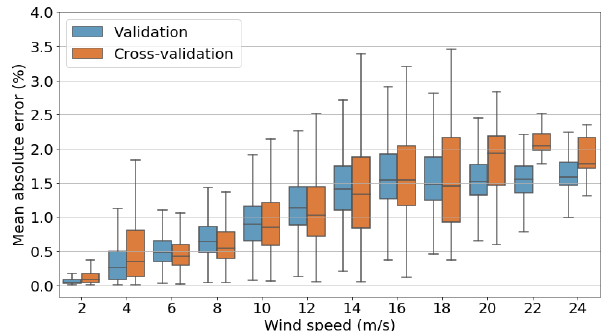
Figure 6. Box plot of MAE of thrust load estimations, expressed as a percentage of the maximal training thrust load value (binned) for the validation and cross-validation turbines plotted against wind